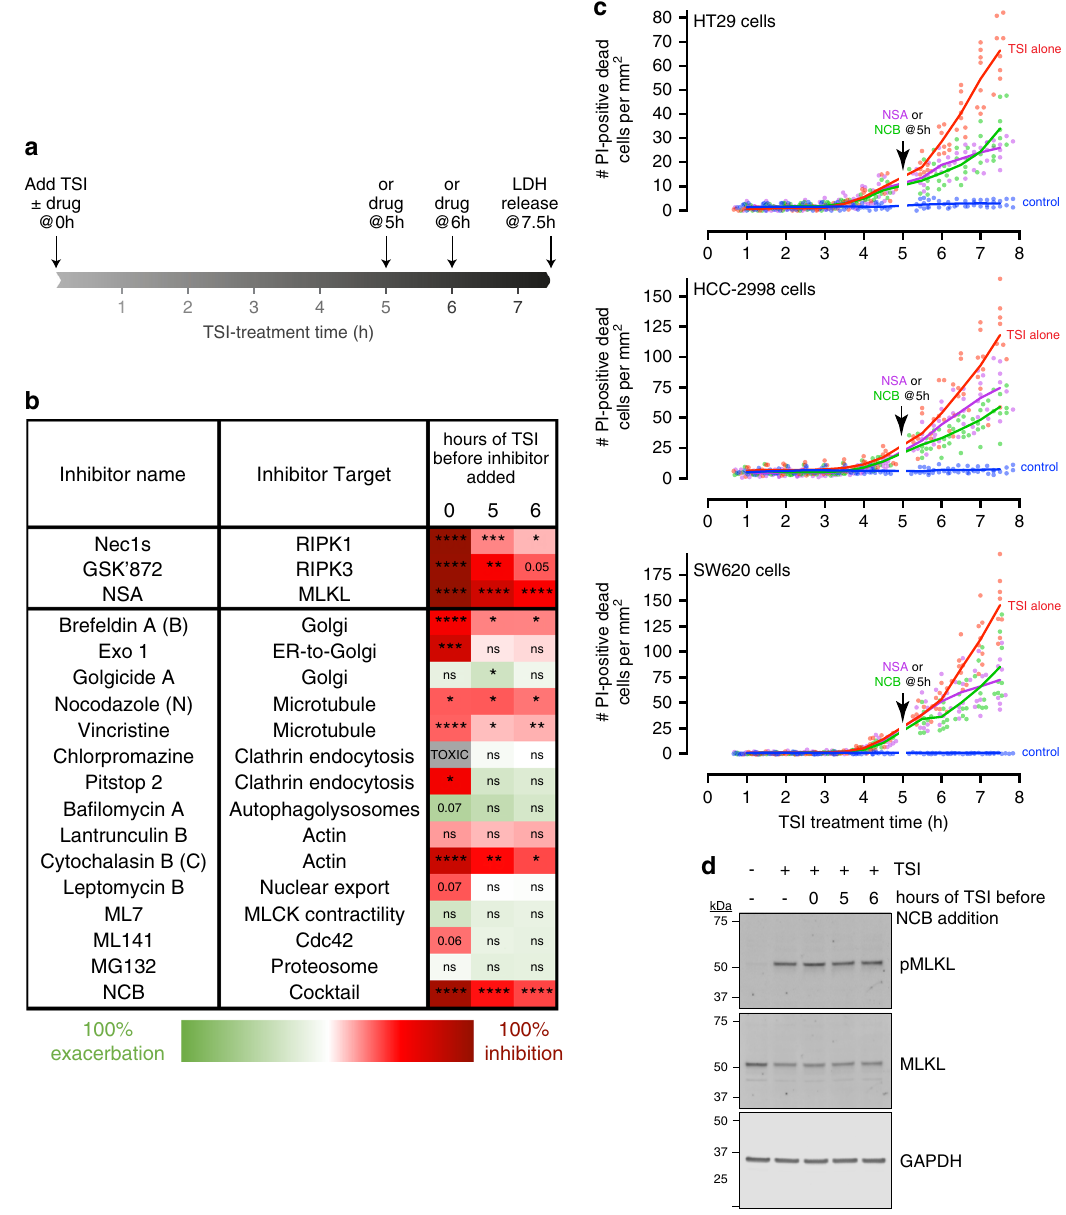
Fig. 6 Intracellular traf fi cking mechanisms govern necroptotic death kinetics. a, b, d The indicated necroptosis-, traf fi cking- or organellar-inhibitors were added to HT29 cells with TNF, Smac mimetic and IDN-6556 (TSI) or 5 – 6 h after TSI-treatment. Plasma membrane lysis ( b ) and MLKL phosphorylation ( d ) were examined 7.5 h post-TSI treatment (as depicted schematically in a ). b Chart summarizes the impact of inhibitors on lactate dehydrogenase (LDH) release (relative to TSI-treated cells). Color coding indicates mean values across n = 3 – 4 independent experiments; ‘ 0% inhibition ’ indicates no LDH release above untreated cells and ‘ 100% exacerbation ’ indicates a doubling of LDH release above TSI-treated cells. Chlorpromazine was toxic upon prolonged exposure (gray). * p < 0.05, ** p < 0.01, *** p < 0.001 and **** p < 0.0001 and p-values between 0.05 and 0.1 are shown as determined by one-way ANOVA with Dunnett ’ s correction for multiple comparisons. Independent datapoints underlying ( b ) are shown in Supplementary Fig. 3a. c HT29, HCC2998 and SW620 cells were left untreated (control) or TSI-treated. Necrosulfonamide (NSA) or Nocodazole, Cytochalasin B, Brefeldin A (NCB) was added after 5 h of TSI-treatment. Propidium iodide (PI) + (dead) cells per mm 2 over time were measured using an IncuCyte S3 System (mean of N = 3 fi elds with >600 cells per group from one experiment with the underlying biological replicates shown as dots; data representative of n = 2 independent experiments). d Immunoblots of whole-cell lysates indicate that NCB does not affect TSI-induced MLKL phosphorylation (representative of n = 2 independent